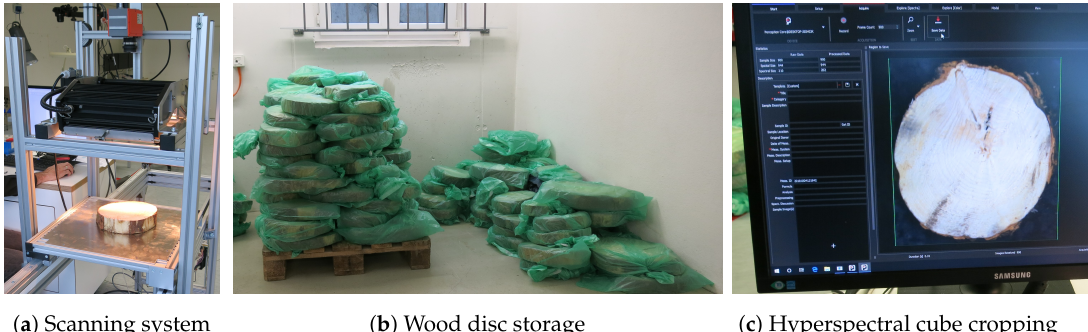
Figure 1. The sensor system shows the line scanner Specim FX10 which was mounted on a metal frame and the slice is moved perpendicular to the scanned line manually. The stored samples were closed airtight to avoid surface changes. Each hyperspectral cube was cropped to reduce the massive amount of